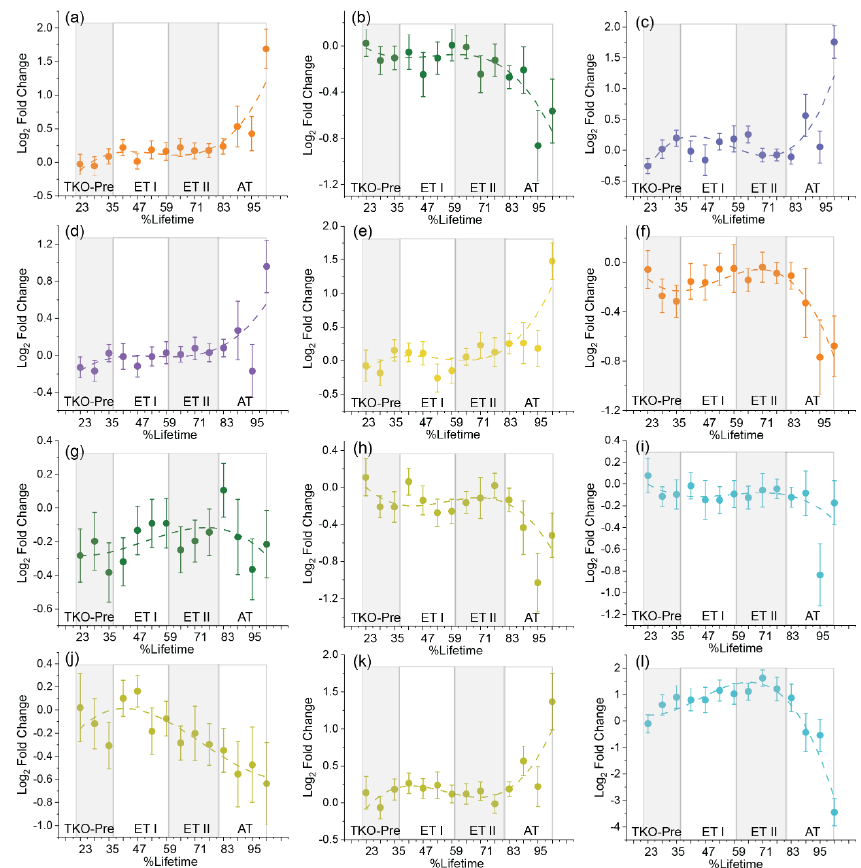
Figure 1. Time − resolved serum lipidomics. Serum abundance fold-changes as a function of %lifetime for ( a ) Ceramides (Cer) ( b ) Sphingomyelins (SM) ( c ) Hexosylceramides (HexCer) ( d ) Phosphatidylcholines (PC) ( e ) Phosphatidylethanolamines ( f ) Lysophosphatidylcholines (LPC) ( g ) Lysophosphatidylethanolamines (LPE) ( h ) Ether PE ( i ) Ether PC ( j ) Short-chain fatty acids (SCFA, carbon chain shorter than 20C) ( k ) very long-chain fatty acids (carbon chain longer than 22C) ( l ) 20 alpha- hydroxyprogesterone. The total abundance for each lipid class was calculated by averaging the relative abundances of all statistically significant lipid species in that class. The x -axis shows the %lifetime, calculated as the ratio of the age of mouse at a given serum sampling time point compared to the total lifespan of that specific mouse. The y -axis shows the fold change calculated as the base 2 logarithm of the lipid content ratios of TKO/TKO ctrl samples. Positive values indicate higher serum levels in TKO animals, and negative values indicate lower serum levels in TKO animals compared to TKO ctrl. Error bars represent the standard error of the log 2 fold change between TKO and control samples. HGSC stage estimate at different %lifetimes are shown. TKO-pre corresponds to premalignant stages, ET-I is early stage 1, ET-II is early stage II and AT is advanced stage.